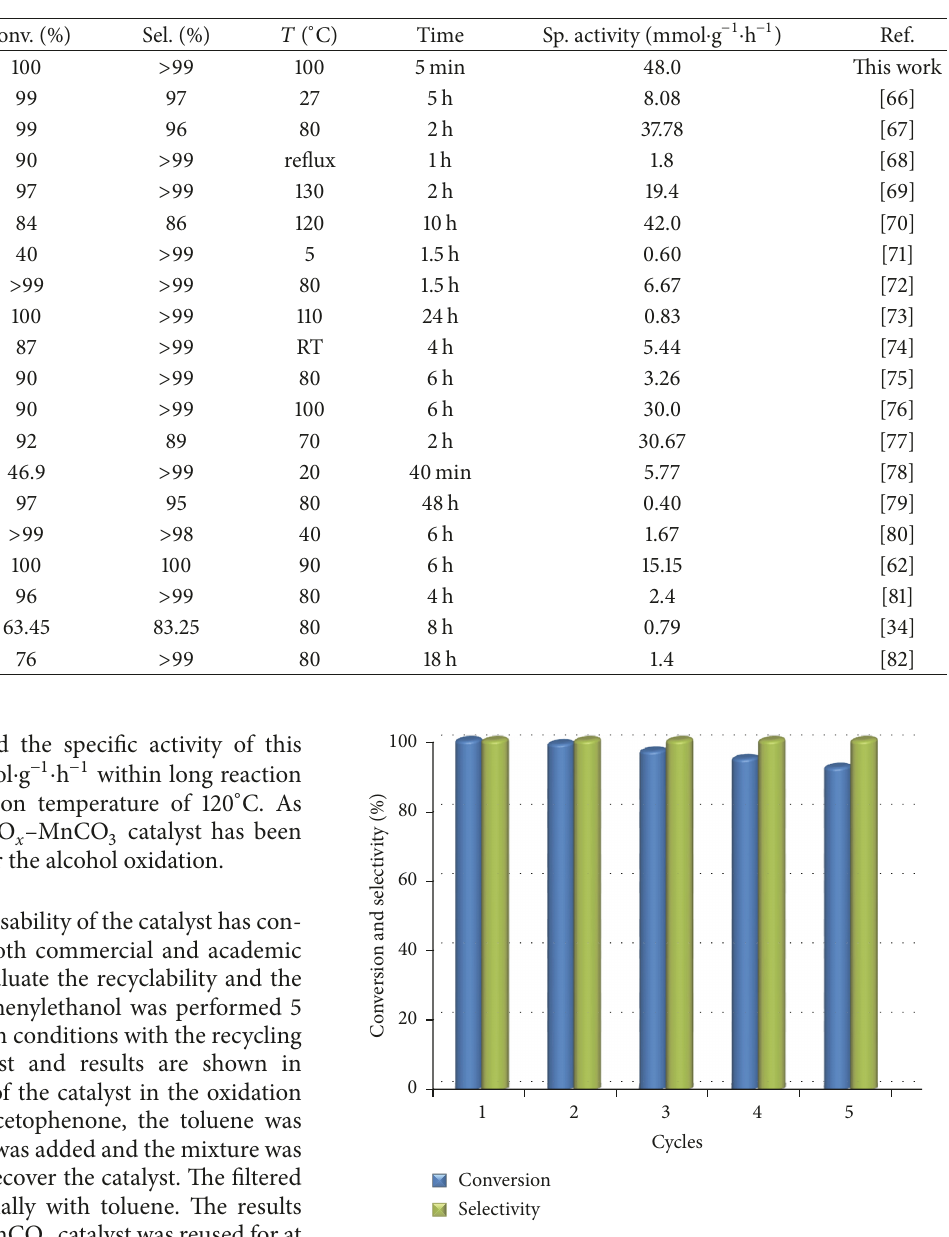
Figure11:Recyclabilityof1%ZnO –MnCO 3 fortheaerialoxidation x of 1-phenylethanol (reaction conditions: 2mmol of 1-phenylethanol, calcination temperature at 300 ∘ C, oxygen with rate 20 mL/min, 0.5 g of catalyst, 10 mL of toluene, reaction temperature at 100 ∘ C, and 5 min of reaction